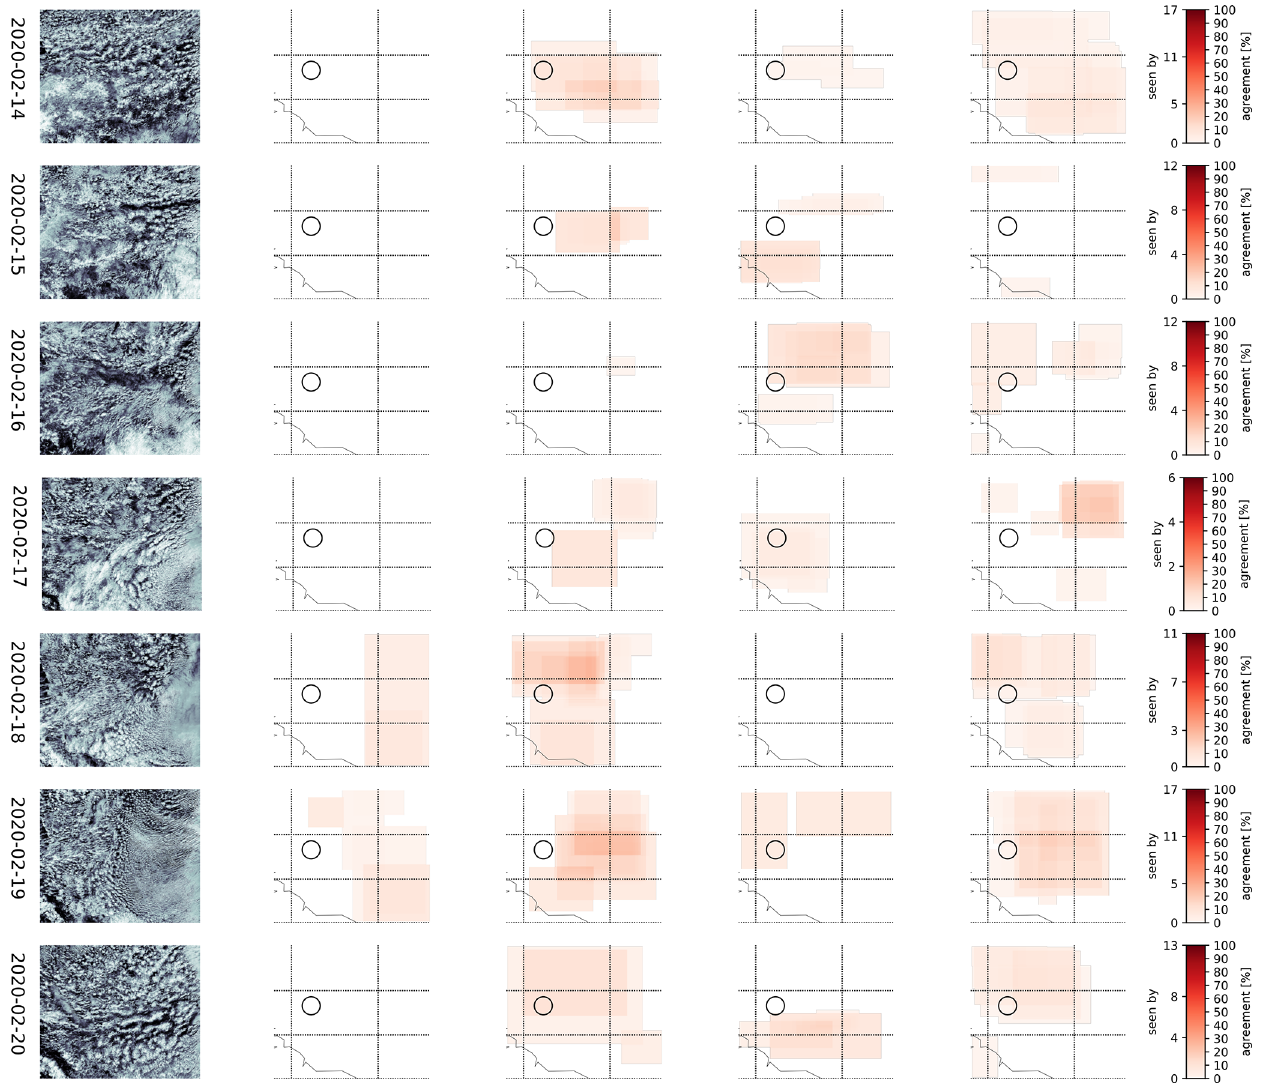
Figure A3. As Fig. A1 but for the ICON albedo workflow. Images show the cloud field at midnight. Please note that the date format in this figure is